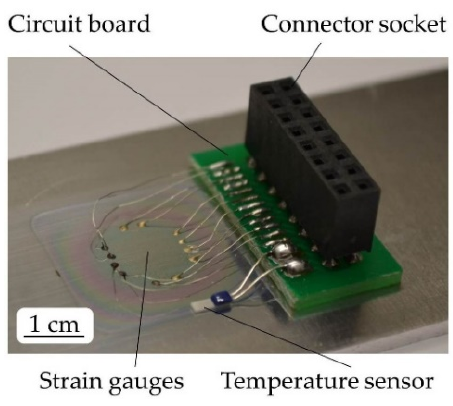
Figure 1. ( a ) Manufacturing steps and contacting of directly deposited strain gauges. ( b ) Four strain gauges after deposition. The quarter-bridge strain gauges are named R1 to R4 and connected to two half-bridge strain gauges. Arrows indicate tensile direction during characterisation.